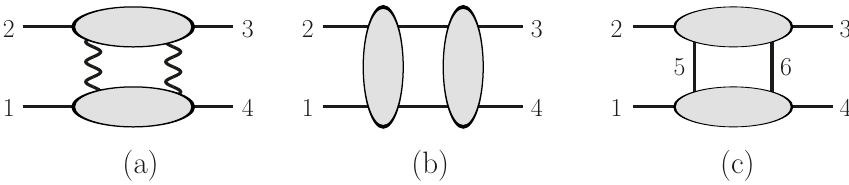
Figure 4 . Generalized two-particle cuts for a elastic scattering of two distinct scalars (cid:30) 1 and (cid:30) 2 with masses m 1 and m 2 . The pairs of legs (1,4) and (2,3) correspond to (cid:30) 1 and (cid:30) 2 respectively. The blobs represent tree amplitudes, which can have several diagrams in a given blob, and exposed lines are all on shell. Cut (a) separates the two matter (cid:12)elds by cutting graviton lines and contributes to the classical potential. The top and bottom internal lines in cut (b) are scalar (cid:30) 1 and (cid:30) 2 , respectively. For cut (c) the internal lines are either both (cid:30) 1 or (cid:30) 2 . Neither of the cuts (b) and (c) contains any new classical potential